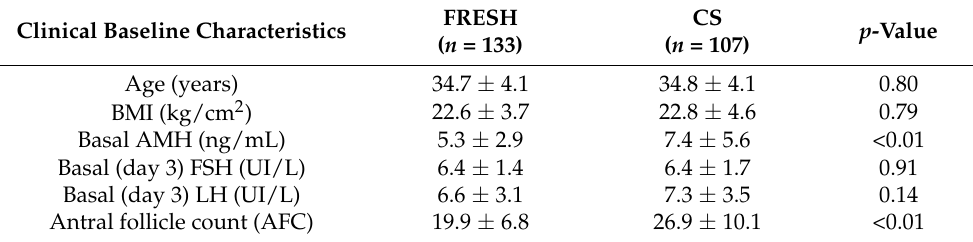
Table 1. Clinical baseline characteristics of the patients receiving fresh embryo transfer (ET) plus human chorionic gonadotropin (hCG) luteal supplementation (FRESH group) vs. those undergoing cycle segmentation with freezing of all embryos and delayed ET (CS group). Data are expressed as mean ± standard deviation.